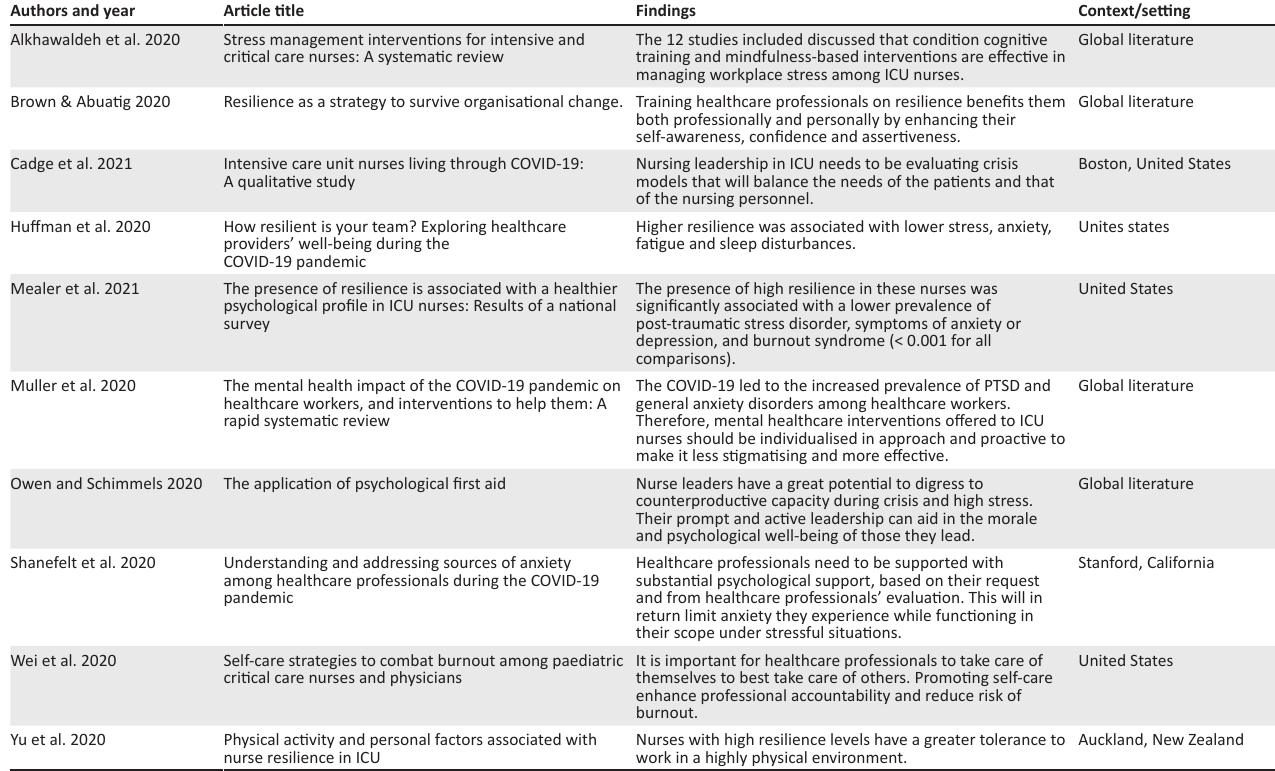
TABLE 2: Details of the data reduction.